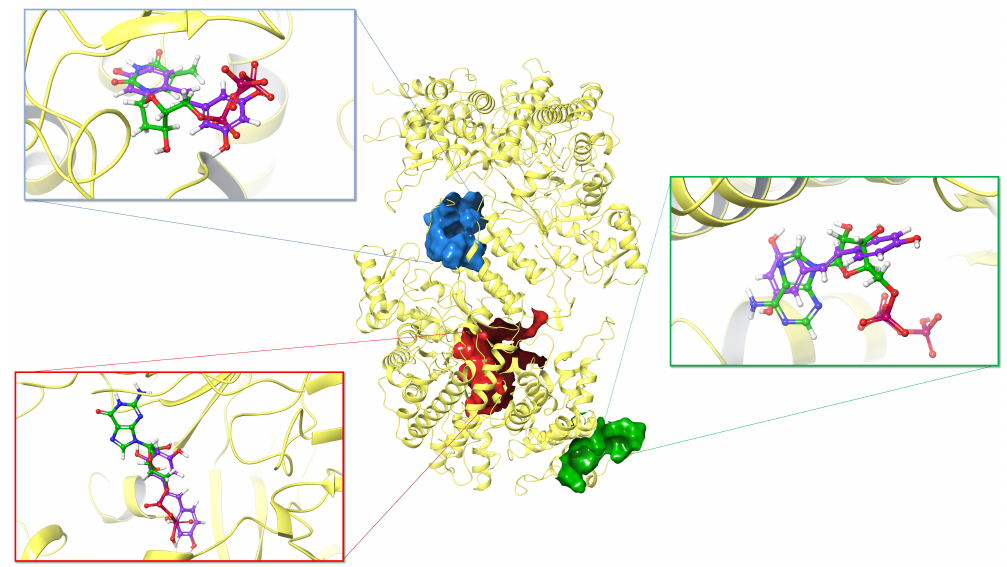
Figure 6. Superposition of the docking poses of trans -resveratrol (purple) and substrates (green) on ribonucleotide reductase (PDB ID: 5TUS). The blue surface refers to the S site, and the substrate inside is TTP; the red surface refers to the C site, and the substrate inside is GDP; the green surface refers to the A site, and the substrate inside is